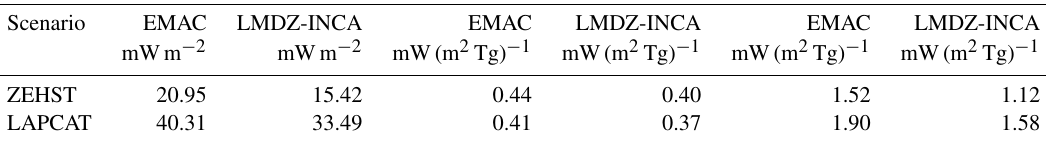
Table 5. Radiative forcing per year in mWm − 2 per teragram of H 2 O perturbation and per teragram of annual water vapor emission (from Table 2), both in mW(m 2 Tg) − 1 , for each scenario and model, calculated with atmospheric composition changes of H 2 O, O 3 , and CH 4 .